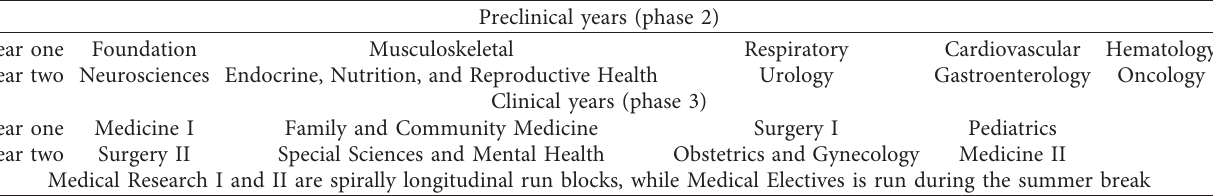
Table 1: Curricular MAP at College of Medicine,